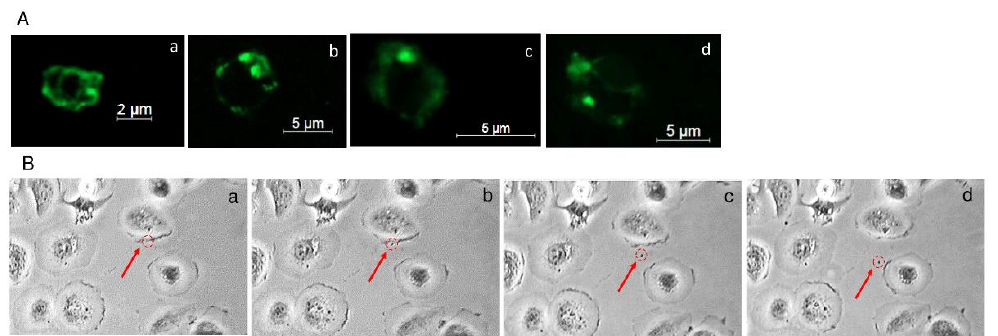
Figure 1. ( A ) EVs from different cell lines labeled with Caveolin-1 and imaged by confocal microscopy: ( a , b )—EVs isolated from CGTH; ( c )—EVs isolated from TPC-1; ( d )—EVs isolated from FTC-133, (green—Alexa Fluor 488); ( B ) Representative images of EVs’ release from the 8505c cell line (automatic sequential microscopic image registration ( a – d ) arrow—released EV).